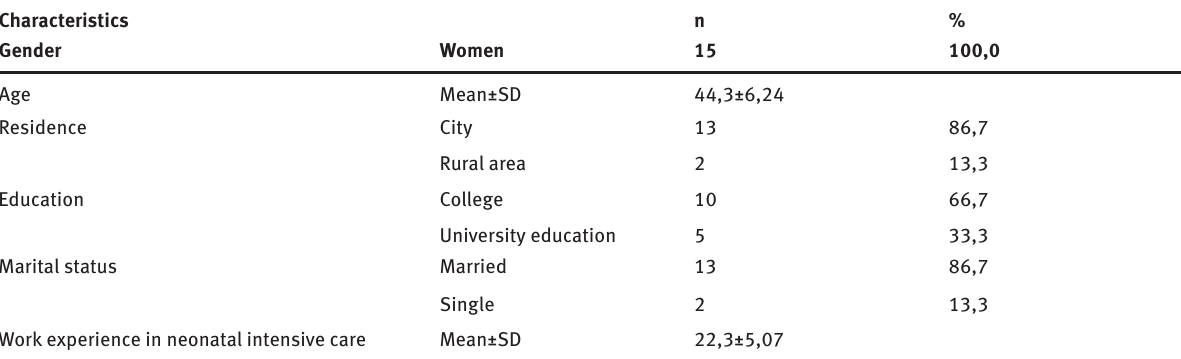
Table 1: Demographic characteristics of study sample